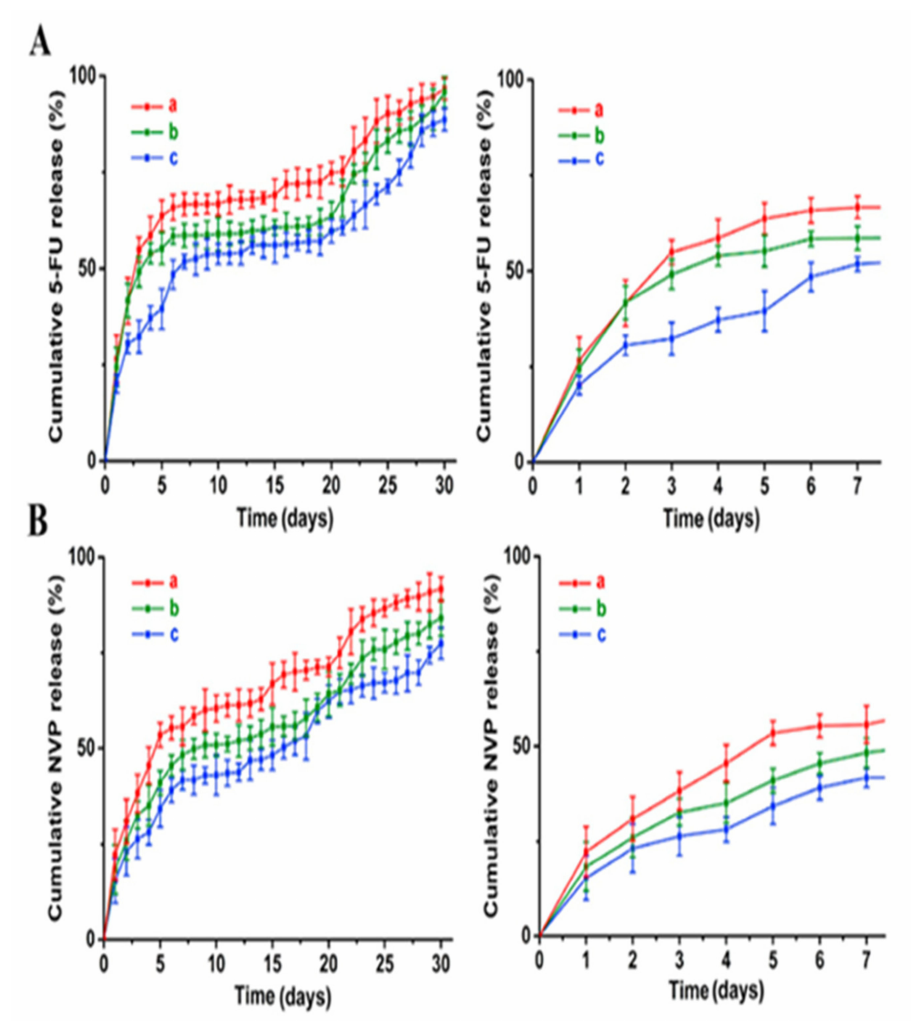
Figure 2. Release profiles of ( A ) 5-FU and ( B ) NVP-BEZ235 in PFN scaffolds with varying aperture sizes, (a) 150 µ m, (b) 100 µ m, (c) 50 µ m, over 7 and 30 days. Reprinted with permission from ref. [57]. Copyright 2019